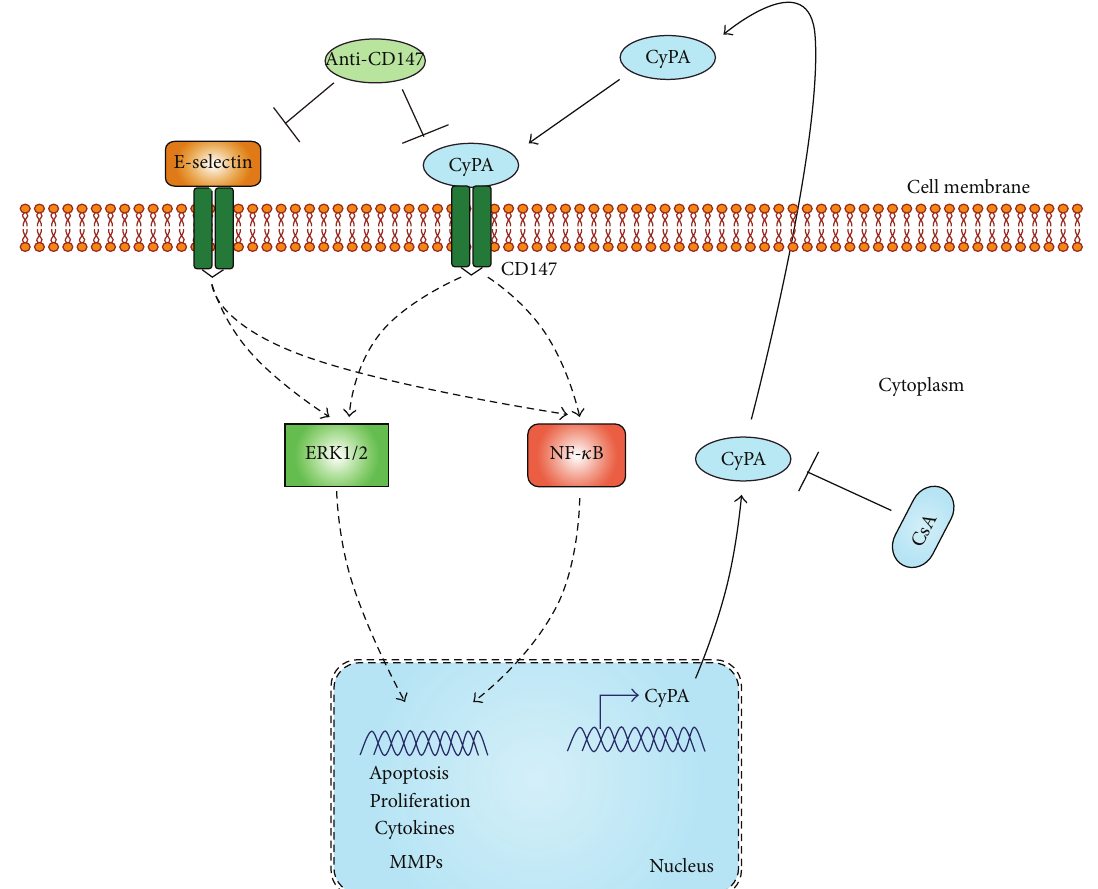
Figure 2: A schematic representation of a proposed mechanism implicated in CyPA/CD147-mediated cell response in AKI. CyPA is overexpressed after CLP and renal dysfunction is significantly attenuated by anti-CD147 antibody intraperitoneally. Specific inhibitor against CyPA might also improve the renal function. CD147 may result in activation of ERK1/2 and NF-kB, involved in cell apoptosis, proliferation, and the product of cytokines and